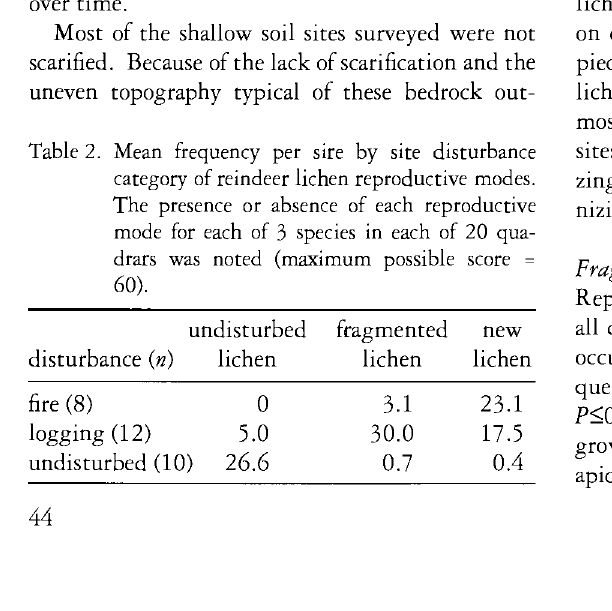
Table 2. Mean frequency per sire by site disturbance category of reindeer lichen reproductive